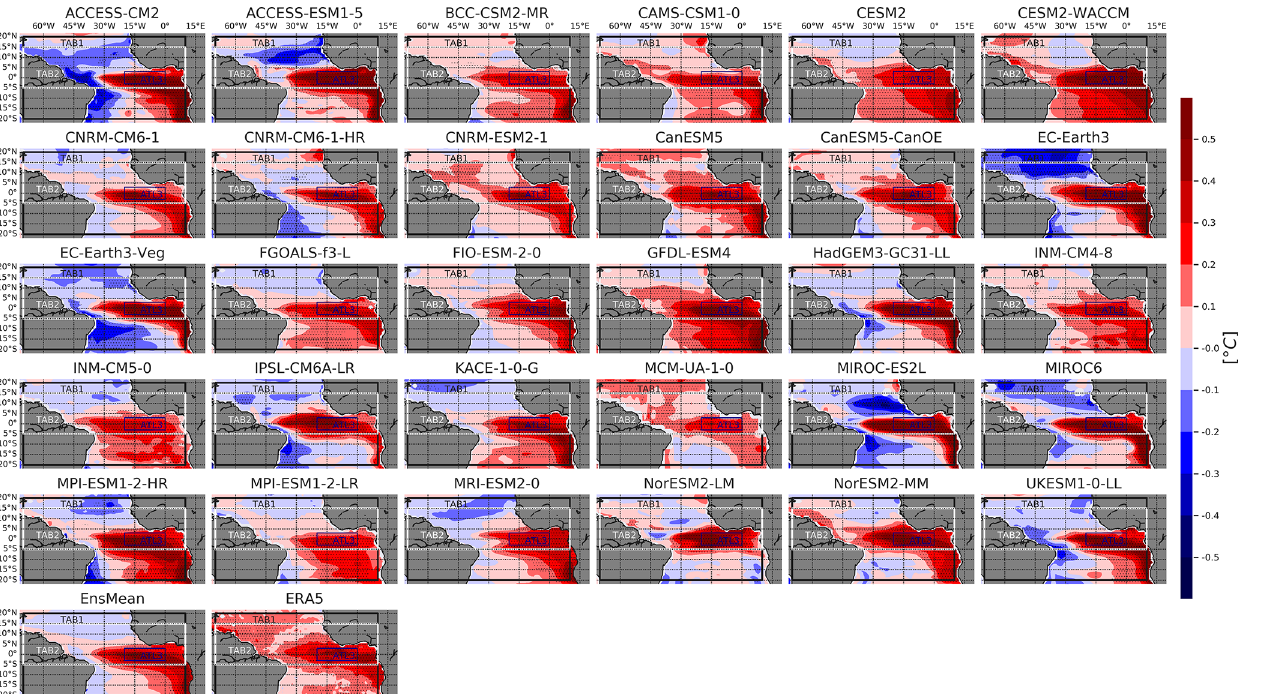
Figure 2. Regression maps of the JAS SST anomalies onto the standardized JAS ATL3 SST index. Stippling in the EnsMean indicates grid points where more than 50% of the models show significant regression at 95% confidence level and more than 80% of the models agree on the sign of the regression coefficient. Stippling in each model and ERA5 indicates significant regression coefficients at 95% level.